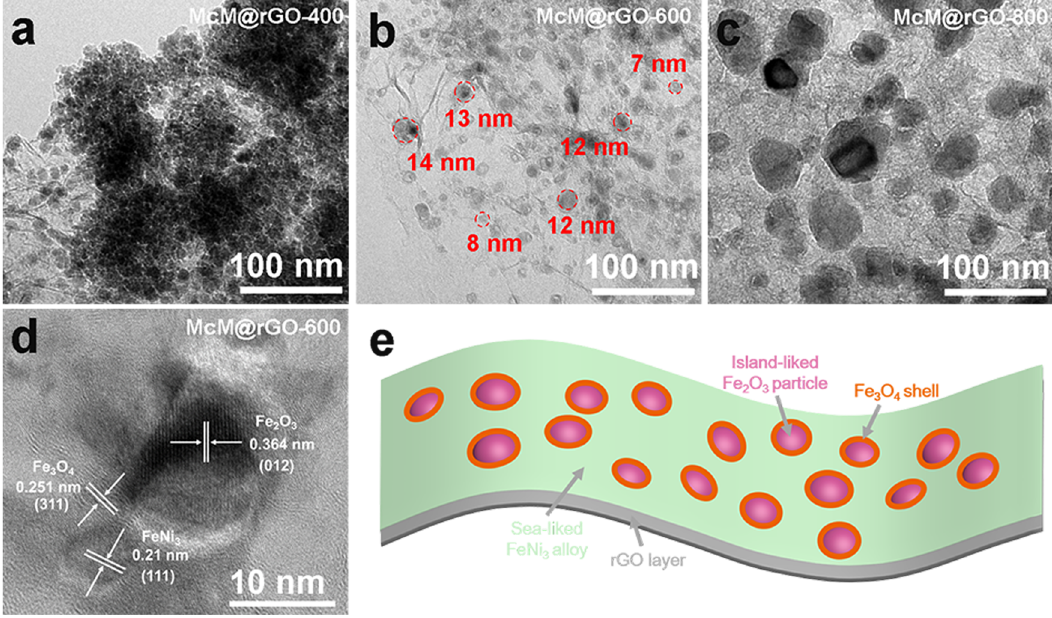
Figure 3: TEM characterizations of McM@rGO synthesized at di ff erent temperatures. TEM images of ( a ) McM@rGO - 400, ( b ) McM@rGO - 600, ( c ) McM@rGO - 800, and ( d ) HR - TEM image of McM@rGO - 600. ( e ) The diagram of the sea - island structure comprised of McMs on the surface of